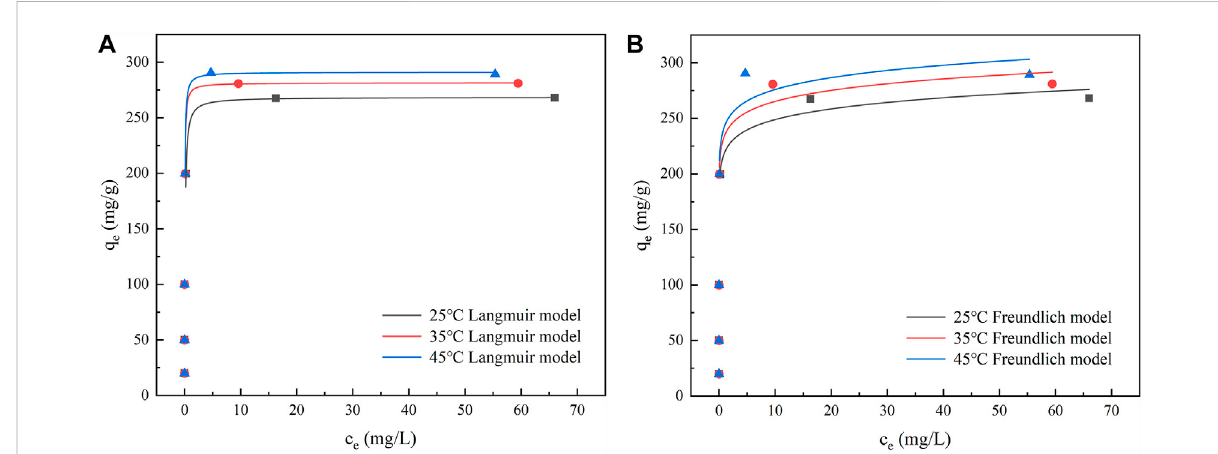
FIGURE 7 Fitting curve of TC adsorption isotherm: (A) Langmuir model; (B) Freundlich model.